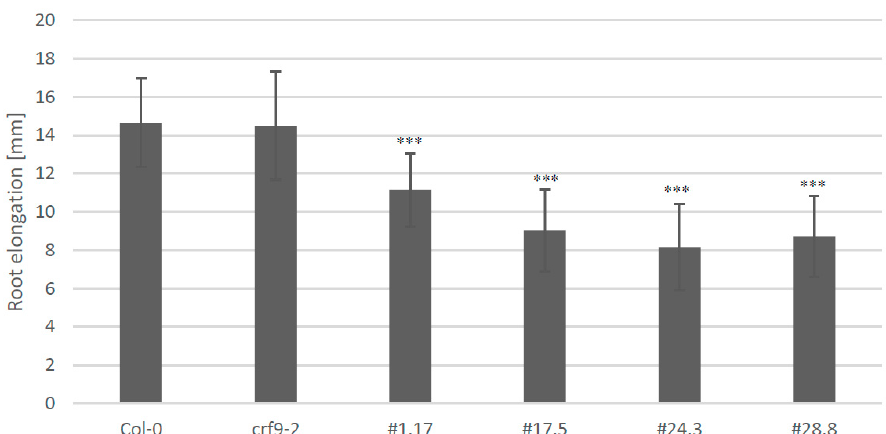
Figure 5. CRF9 overexpression leads to a shorter primary root. Plants were grown on 0.5 × MS media under long-day conditions in the growth chamber. The tip of the primary root was marked on the third and tenth day after germination and the root elongation was determined using the program ImageJ (www.imagej.nih.gov/ij/ accessed on 21 December 2022). Level of significance in a one-sided t -test: *** = p < 0.001.